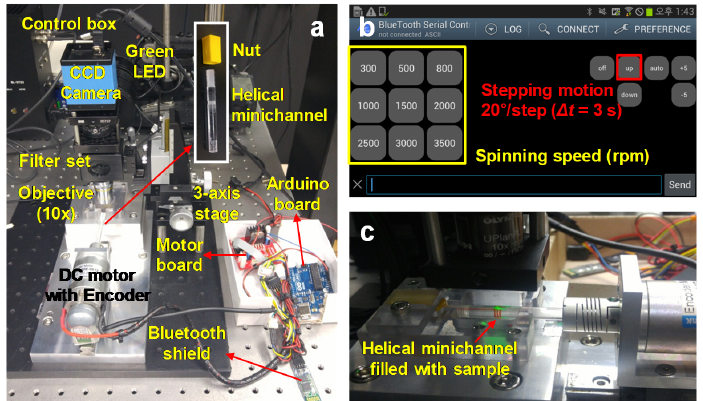
Figure 1. ( a ) Two-color-fluorescence imaging configuration with a Bluetooth-controlled DC (direct current) motor system; ( b ) smartphone application for motor control with an Arduino board; ( c ) helical minichannel filled with blood sample during acquisition of fluorescent cell images for counting.